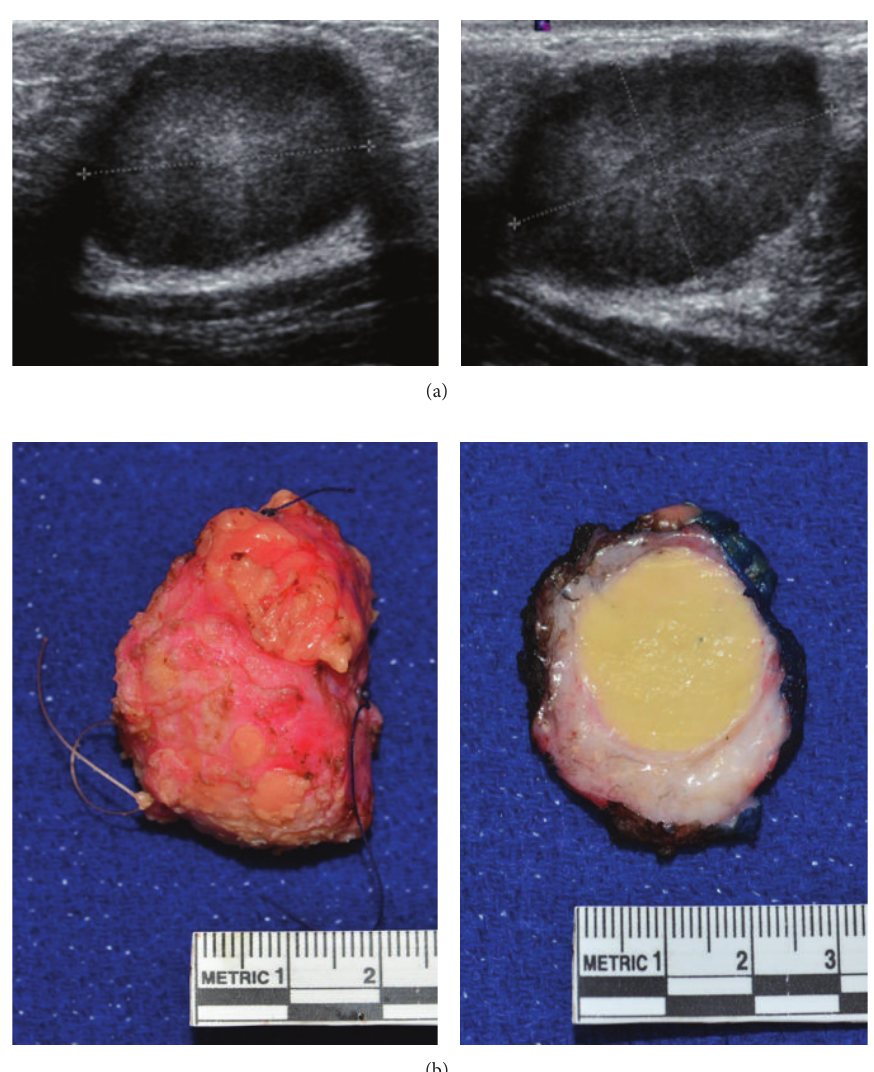
Figure 1: (a) Ultrasound images of a granular cell tumor of the breast showing a solitary mass without vascularity. (b) Gross pathologic images of the resected granular cell breast